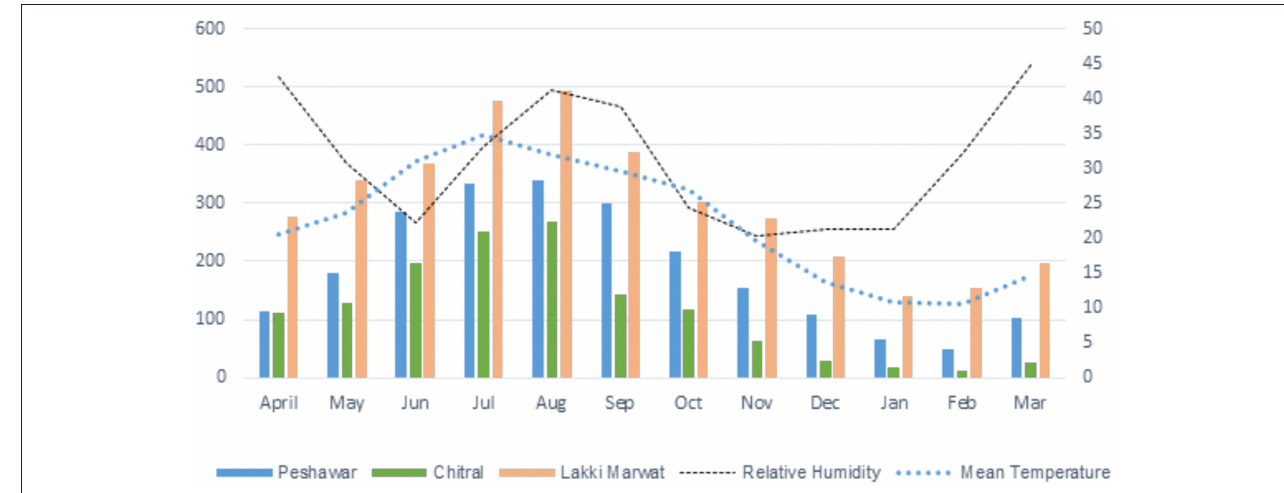
FIGURE 3 | Chart showing spatial distribution of Argas ticks in selected districts of KP.